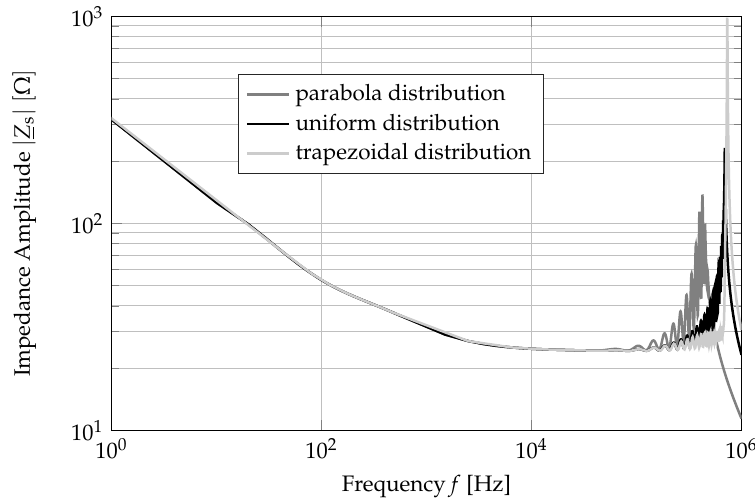
Figure 7. Amplitude of cable impedance at sending end for different length distribution profiles of PI-sections, n PI = 20, (cid:96) =